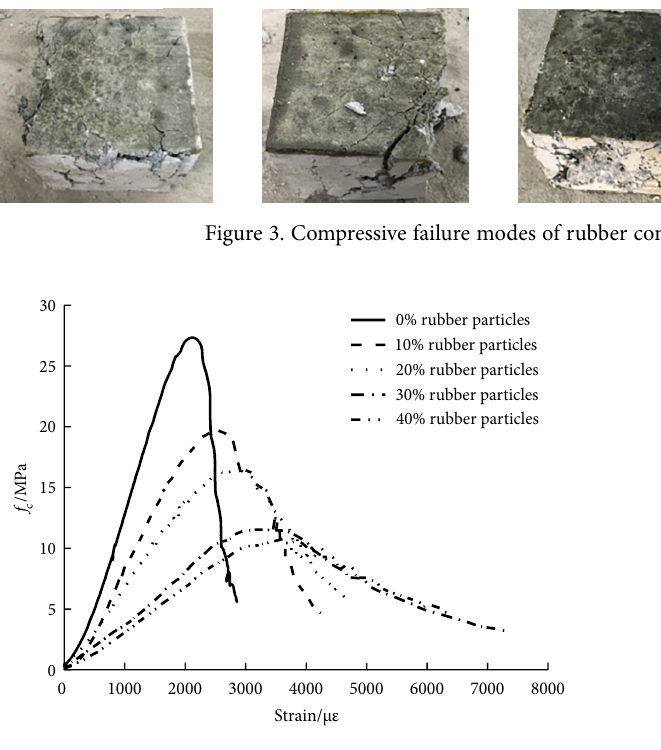
Figure 4. Stress-strain curves of rubber concrete with different substitution rates under uniaxial compression